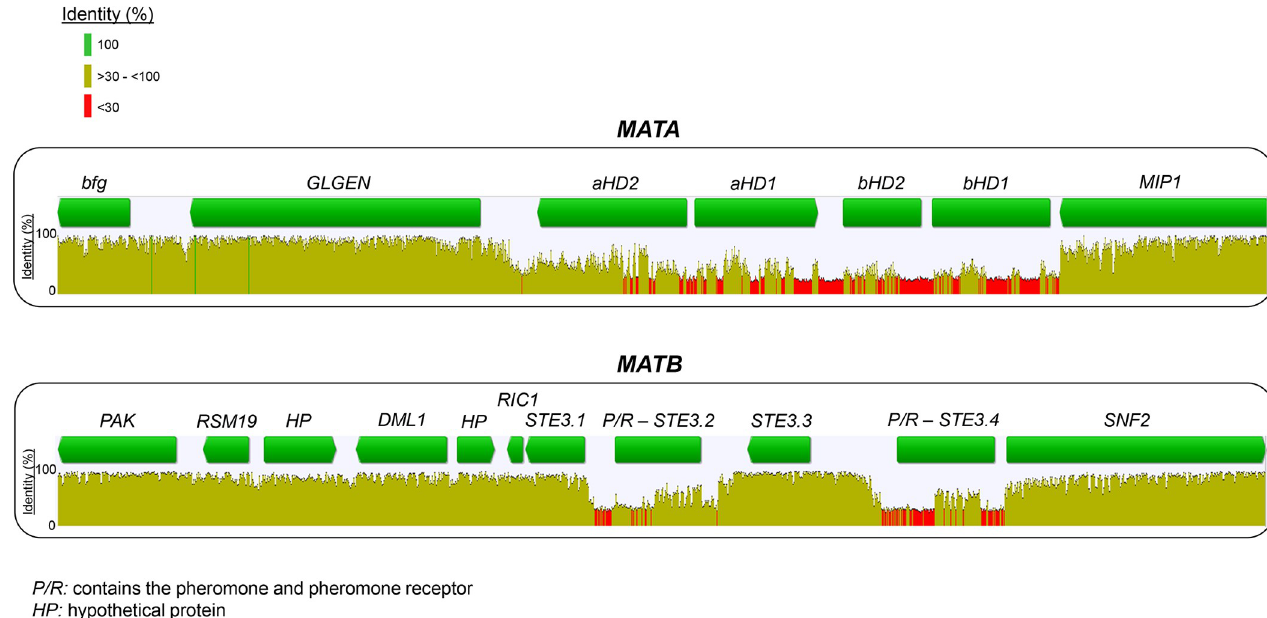
Fig 4. High nucleotide diversity among mating genes. Identity values of nucleotide alignments for MATA and MATB regions are displayed. Gene arrows indicate the coding direction; however, when gene direction differed among strains (Fig 5), we represented a green rectangle. Bar colors represented the level of identity according to the legend. Geneious’ identity values were calculated based on each nucleotide position and represent the percentage (y-axis) of sequences with an identical nucleotide compared to the consensus sequence. The MATA alignment includes 175 isolates (3 species), excluding those isolates found to split the region in potentially different chromosomal locations (S3 Table). The MATB alignment includes 179 isolates (3 species), excluding those isolates found to split the region in potentially different chromosomal locations (S3 Table).